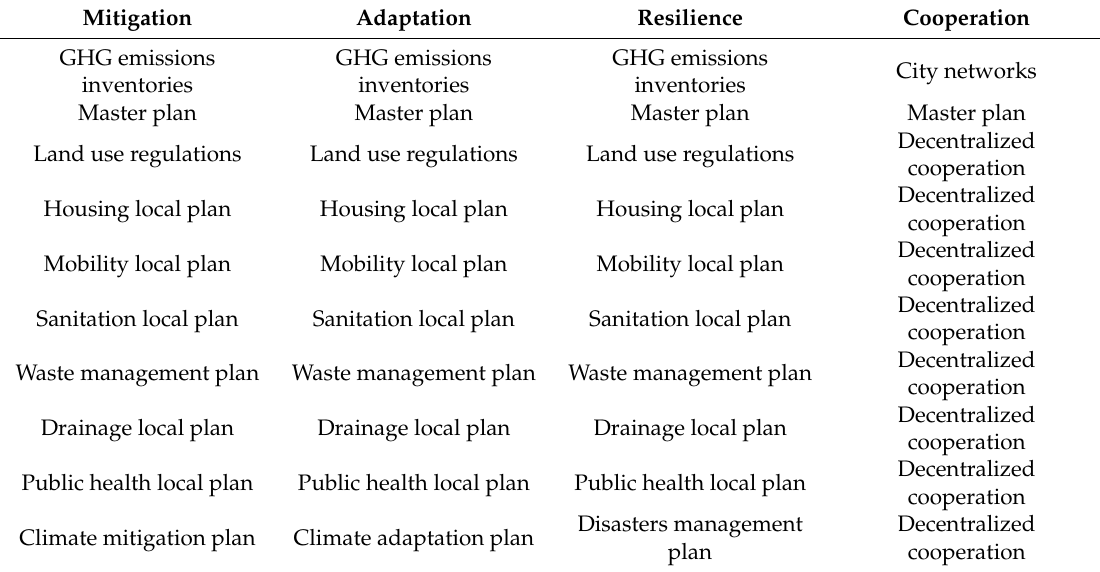
Table 2. Local policies, plans, programs, and